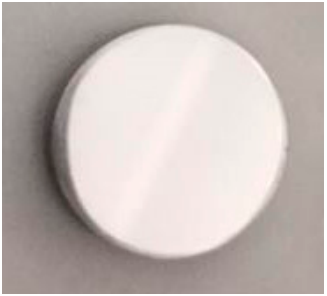
Figure 1. Type 304 stainless steel sample in a circular shape.